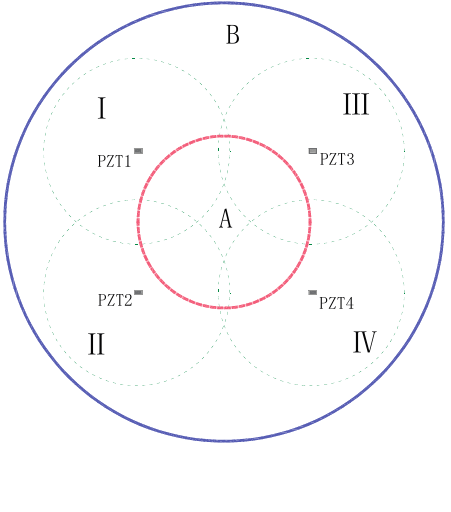
Figure 8. Diagram of the damage areas detected by